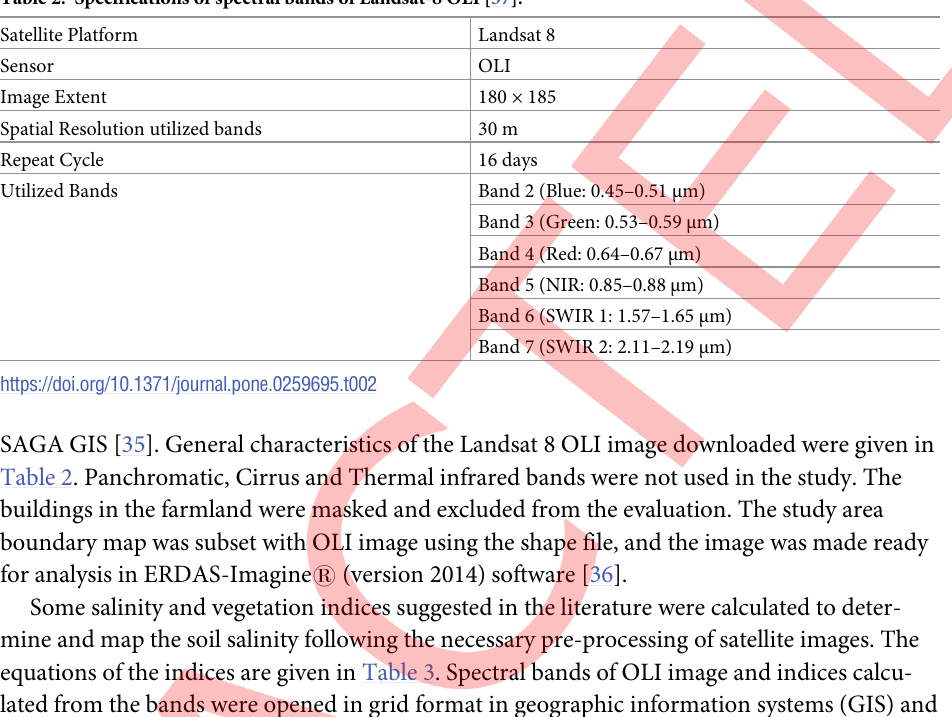
Table 2. Specifications of spectral bands of Landsat-8 OLI [37].